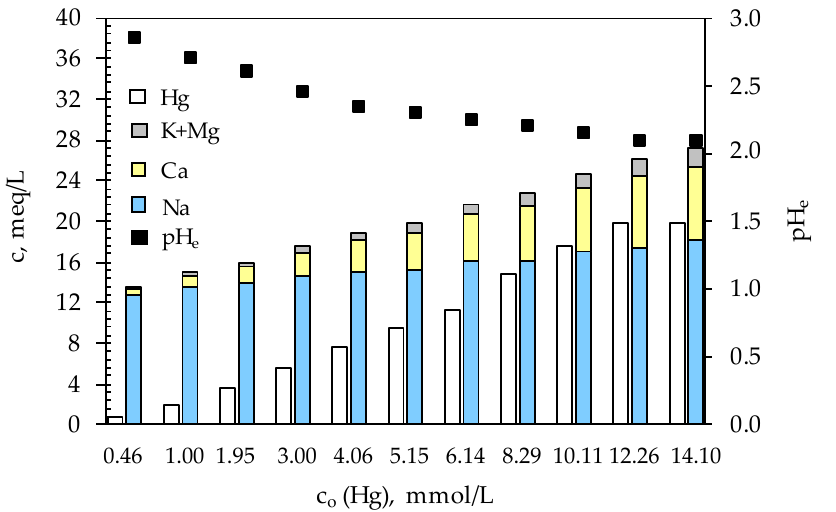
Figure 15. Relationship between the amount of sorbed Hg(II) and the released exchangeable zeolite cations and pH e as a function of the initial Hg(II) concentration.